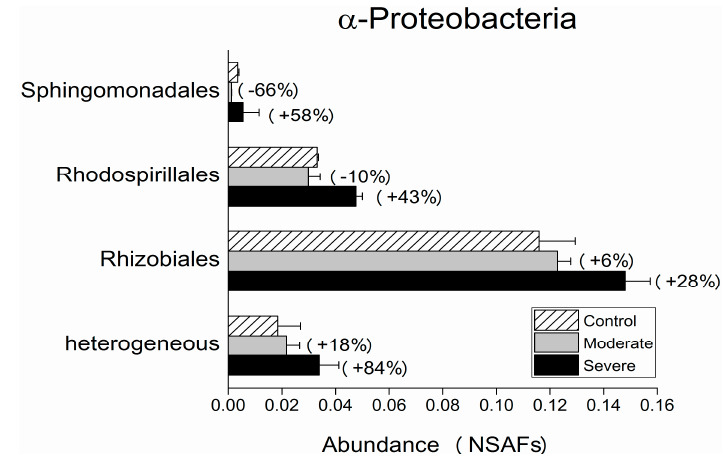
Figure 1. Phylogenetic network of proteins. Relative abundances calculated from the sum of the normalized spectral abundance factor (NSAFs) found for the control and drying and rewetting (DRW) plots: (A), moderate DRW—two consecutive cycles of four weeks of drought, then 75 mm irrigation (1 mm of precipitation refers to 1 L water m -2 ); (B), severe DRW—one cycle of eight weeks of drought, then 150 mm irrigation. The size of the nodes and labels represent the abundance of the corresponding taxonomic group. Labels are class-level assignments and shape-indicators are: Diamond , not present in control and treatments; Triangle , present in control but not in treatment; Rectangle , not present in control but in treatment; and Circle , present in both control and treatments. For the proteins that were present in both treatments (shown in circles) the gradient of color represents the increase (red) or decrease (blue) of the % change in the relative abundance of the treatment plots compared with control. ‘Heterogeneous’ means different microbial taxa that belong to more than one phylum/class/order. Values are means of two analytical replicates of four pooled biological replicates. Detailed changes of the percentage values in DRW treatments (as compared to controls) can be found in Supplementary Table 1.